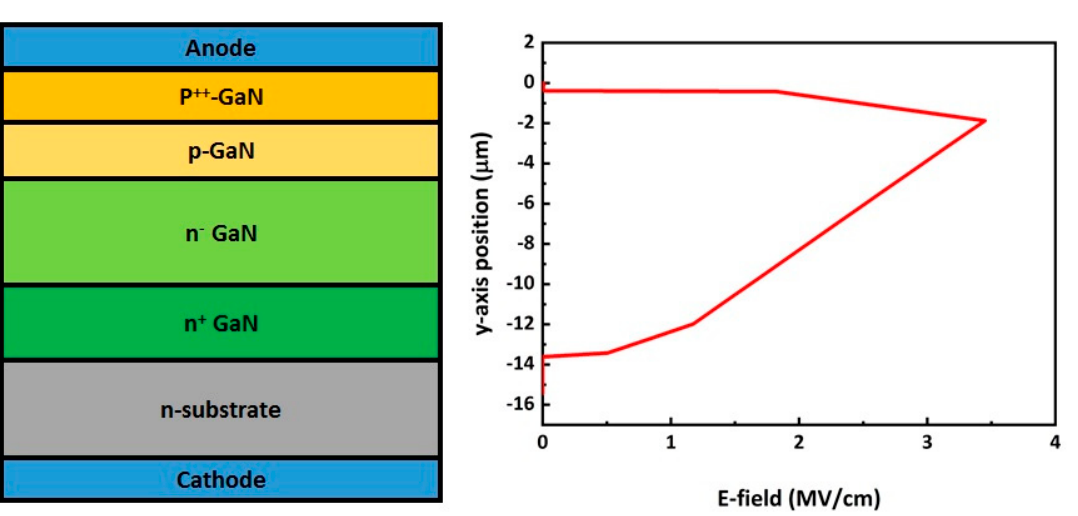
Figure 6. The electric profile along the midline for the planar model at a reverse bias of 2983 V.